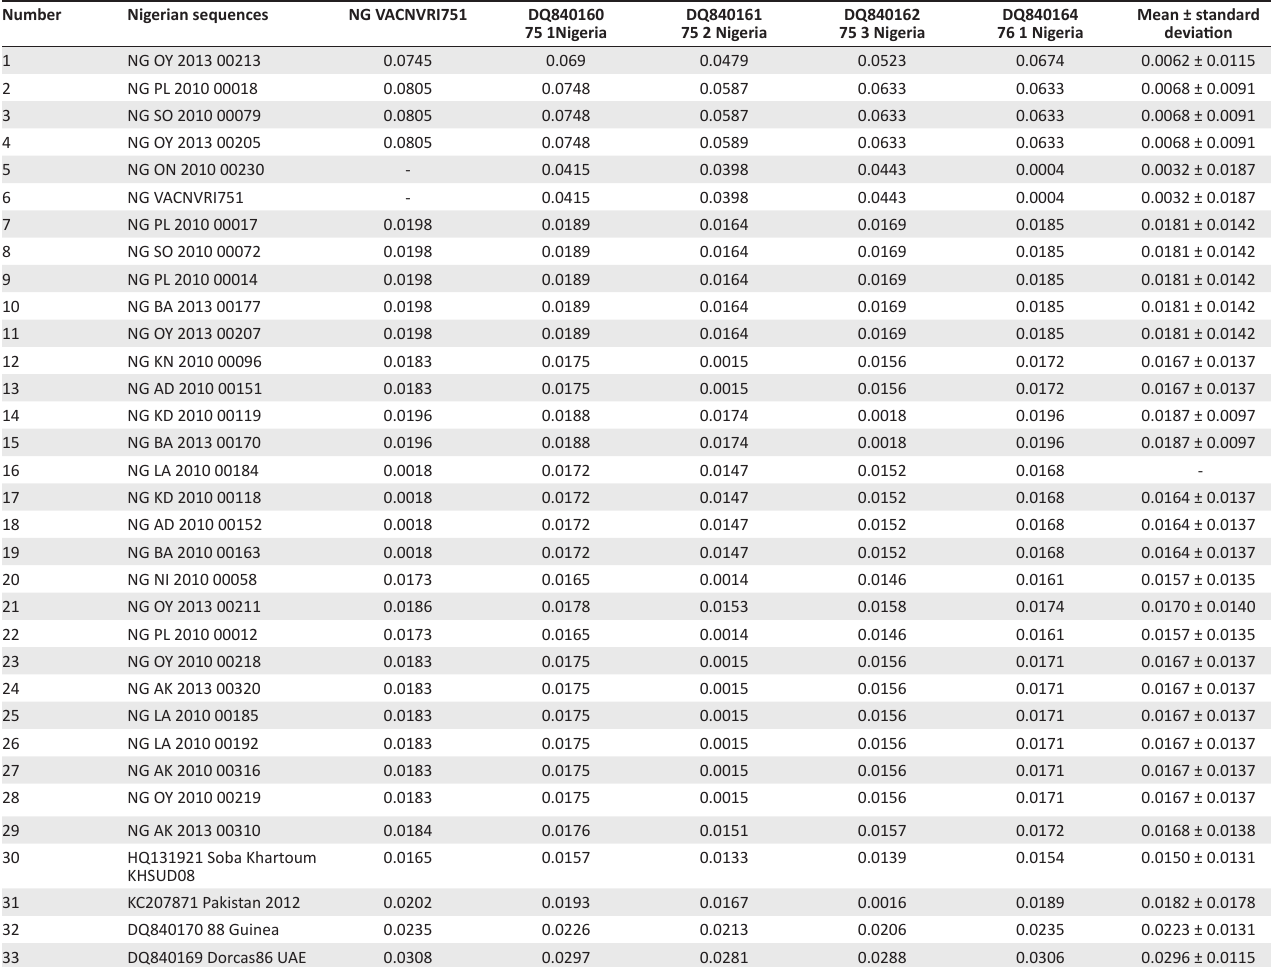
TABLE 4: Genetic distances between peste-des-petits-ruminants virus N GenBank Nigerian sequences and the recent Nigerian sequences, using a general time-reversible model with a gamma-shaped distribution of rate variation across sites (GTR + G). Number Nigerian